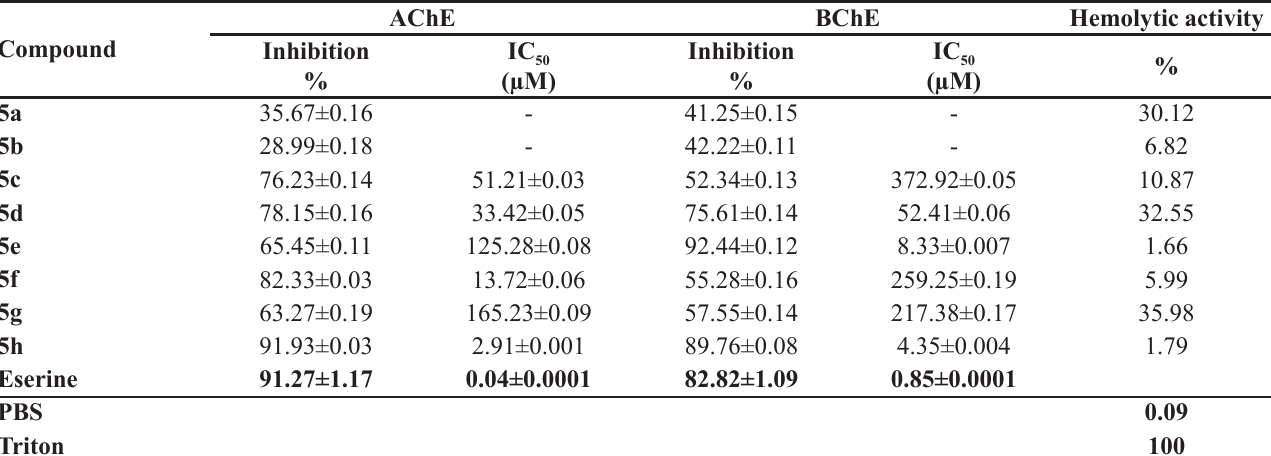
TABLE I - Bioactivity studies of different 2-furyl(4-{4-[(substituted)sulfonyl]benzyl}-1-piperazinyl)methanone derivatives ( 5a-h )